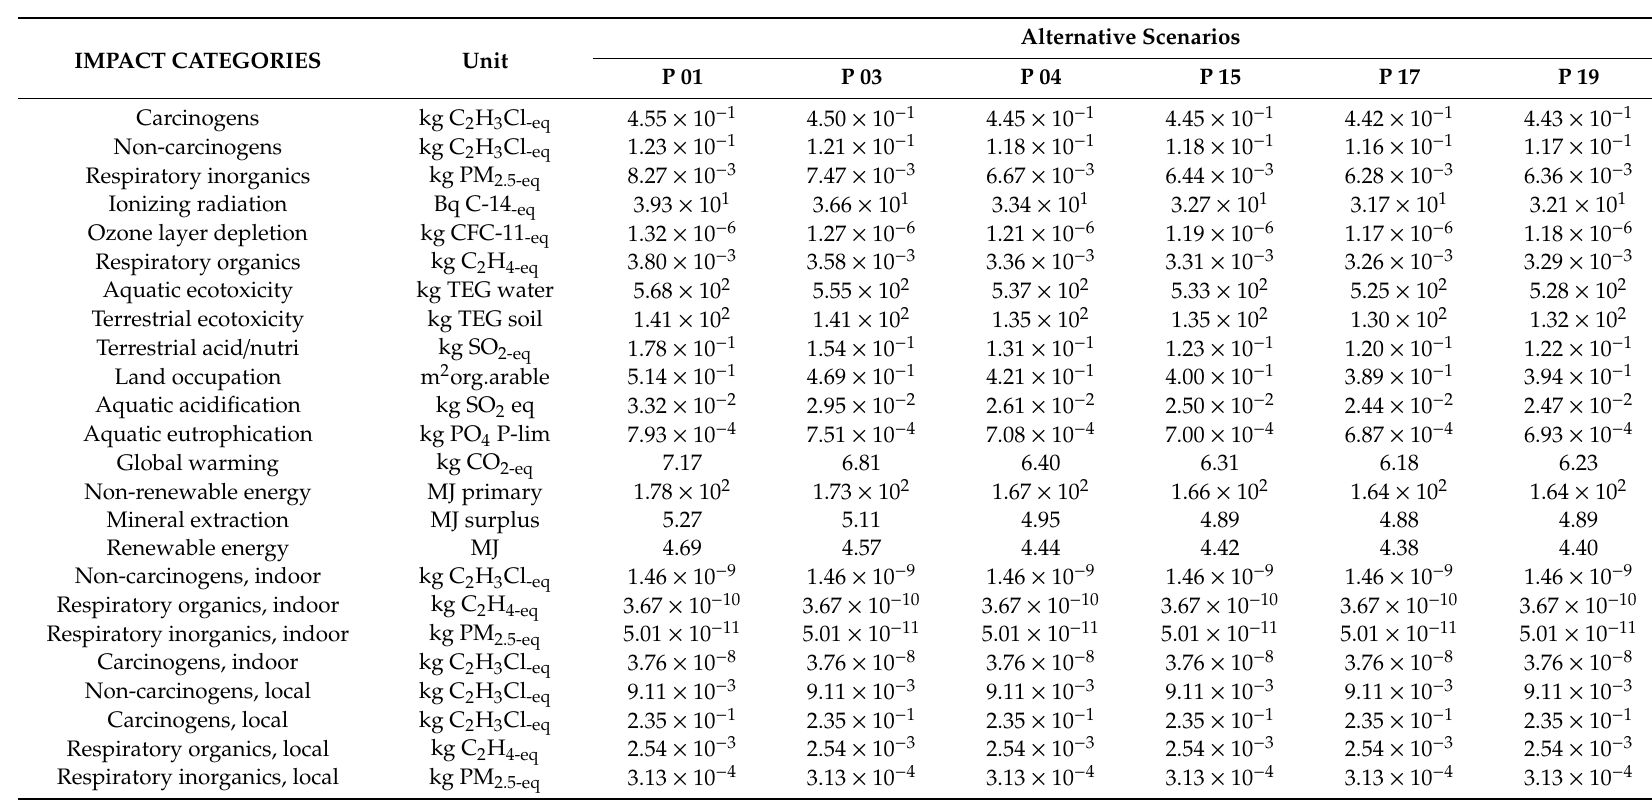
Table 2. Lifecycle assessment (LCA) for 1 m 2 of ceramic